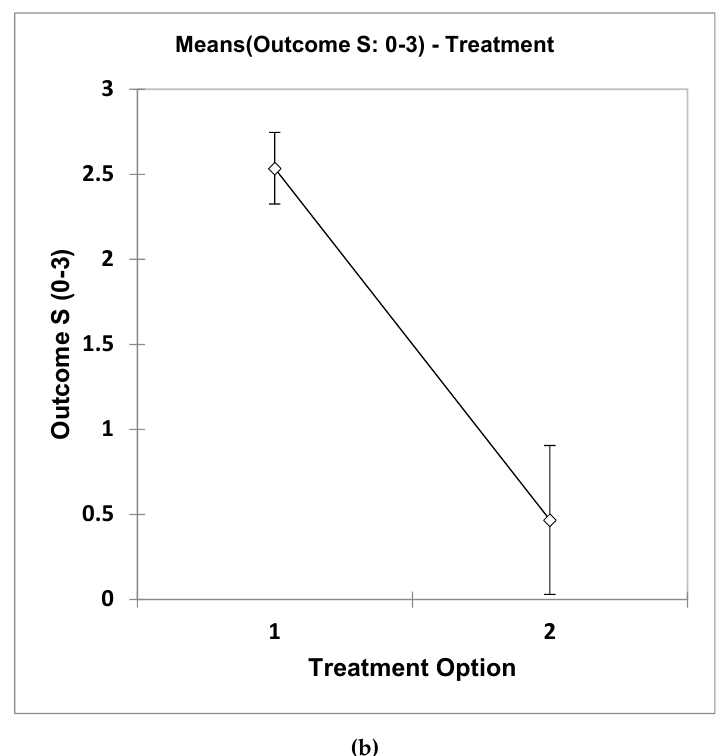
Figure 2. ( a ), Estimated mean ± 95% confidence intervals (CIs) for component 1 variable importance parameter (VIP) values for each potential “predictor” variable included in the multivariate PLS-R analysis model applied to the sample size-weighted systematic review dataset. VIP values are considered statistically significant if the lower 95% CI is > 1.00, and therefore only treatment option (1 or 2) was found to be a significant contributory variable towards clinical outcome score. ( b ) Plot of mean ± 95% CI values for the two treatment options obtained from the univariate ANCOVA of the full dataset. Treatments 1 and 2 correspond to pre- and post-laser treatment options, respectively.